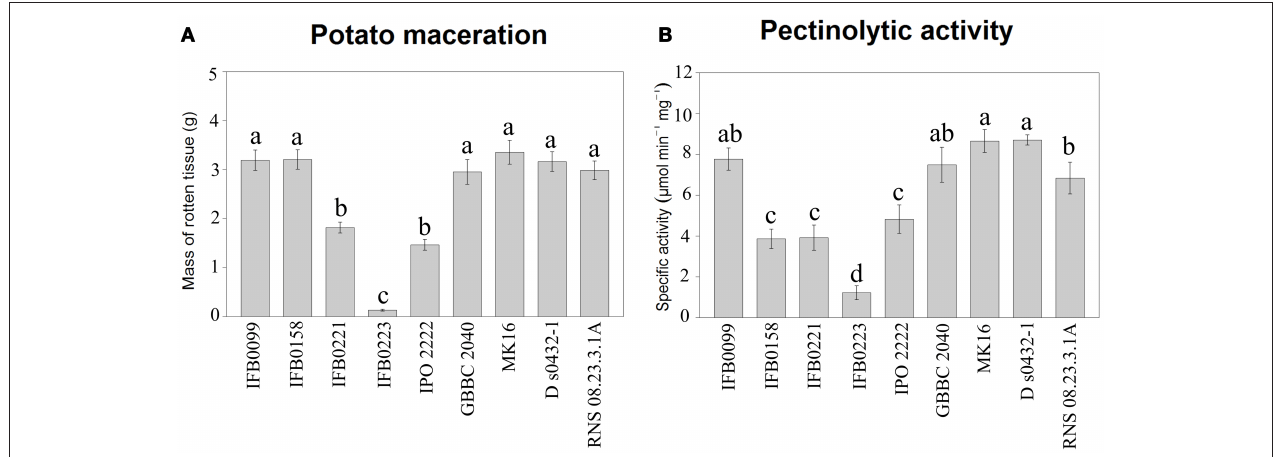
FIGURE 2 | Potato tuber tissue maceration ability and pectinolytic activity of the D. solani strains. (A) Maceration ability in grams of macerated tissue, 48h post inoculation. (B) Total pectate lyase specific activity ( µ mol min − 1 mg − 1) in the presence of polygalacturonic acid. Means ± standard errors are depicted, n = 10 for (A) and n = 3 for (B) . Within each panel mean values marked with different letters are significantly different by Kruskal–Wallis test followed by post hoc analysis using Fisher’s least significant difference criterion (R agricolae package). All statistical hypotheses were tested at p < 0.05.